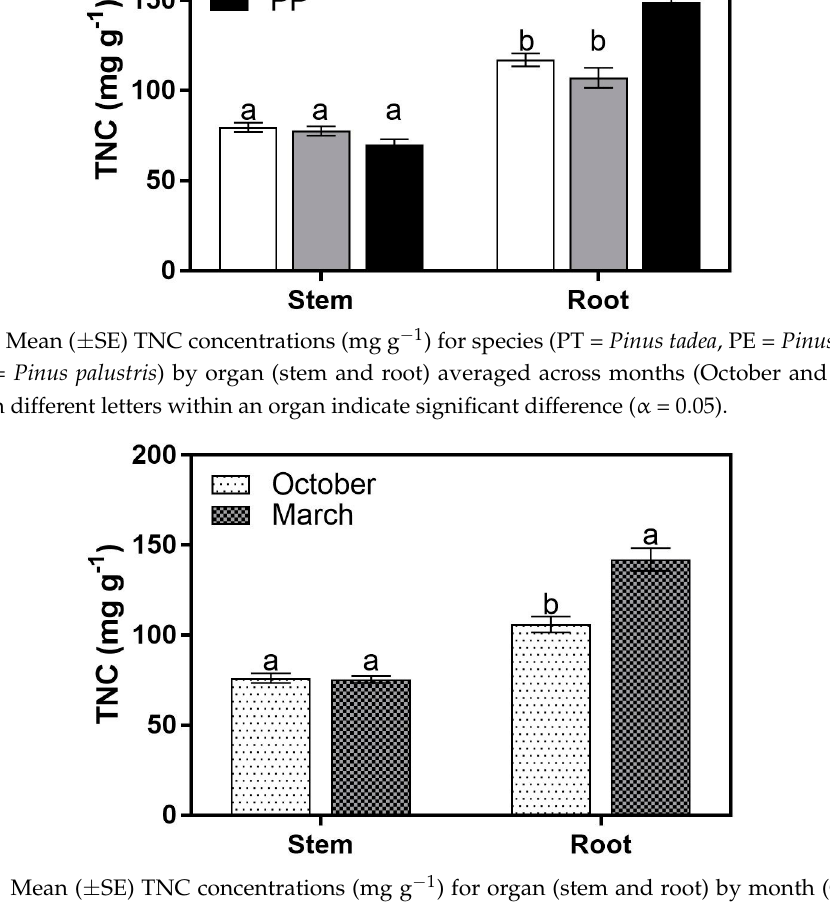
Figure 5. Mean (±SE) TNC concentrations (mg g − 1 ) for organ (stem and root) by month (October and March) averaged across species (PT = Pinus tadea , PE = Pinus elliottii , and PP = Pinus palustris ). Bars with different letters within an organ indicate significant difference ( α = 0.05).